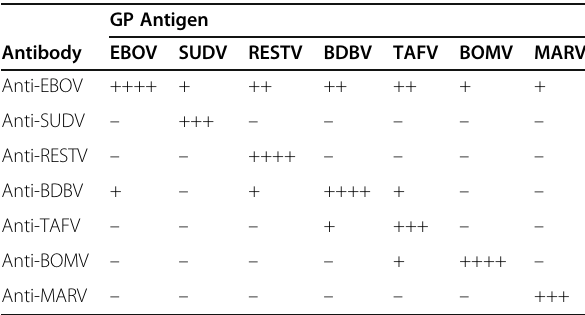
Table 1 Indirect ELISA to compare reactivity of recombinant GP proteins from EBOV, SUDV, RESTV, BDBV, TAFV, BOMV and MARV with polyclonal antibodies against all seven viruses (++++ = O.D. > 4.0, +++ = O.D. 3.0 – 4.0, ++ = O.D. 2.0 – 3.0, + = O.D. > 0.5 – 2.0). - = non-reactive. As expected, some cross-reactivity